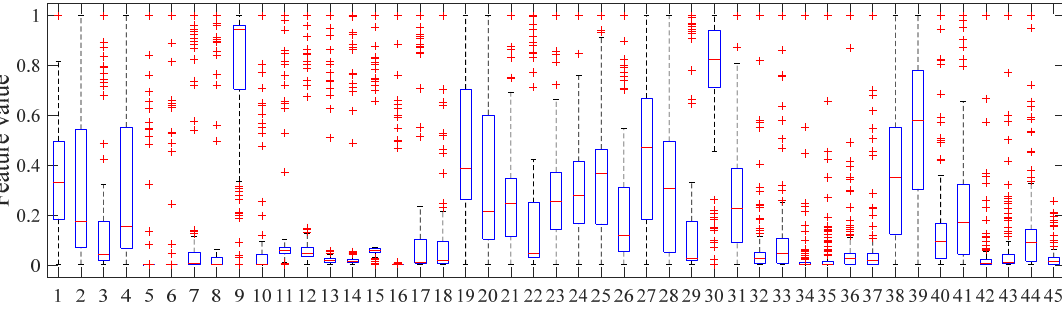
Figure 11. Time − domain diagram of three states of one − way valve. Figure 11. Time-domain diagram of three states of one-way valve.